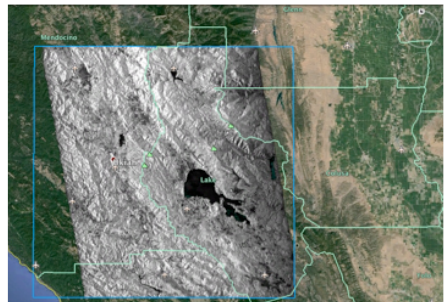
Figure 7. KML overlay of terrain corrected SAR amplitude